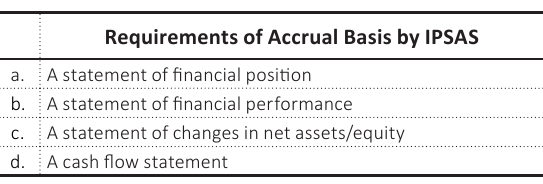
Table 11. Requirements of accrual basis by IPSAS